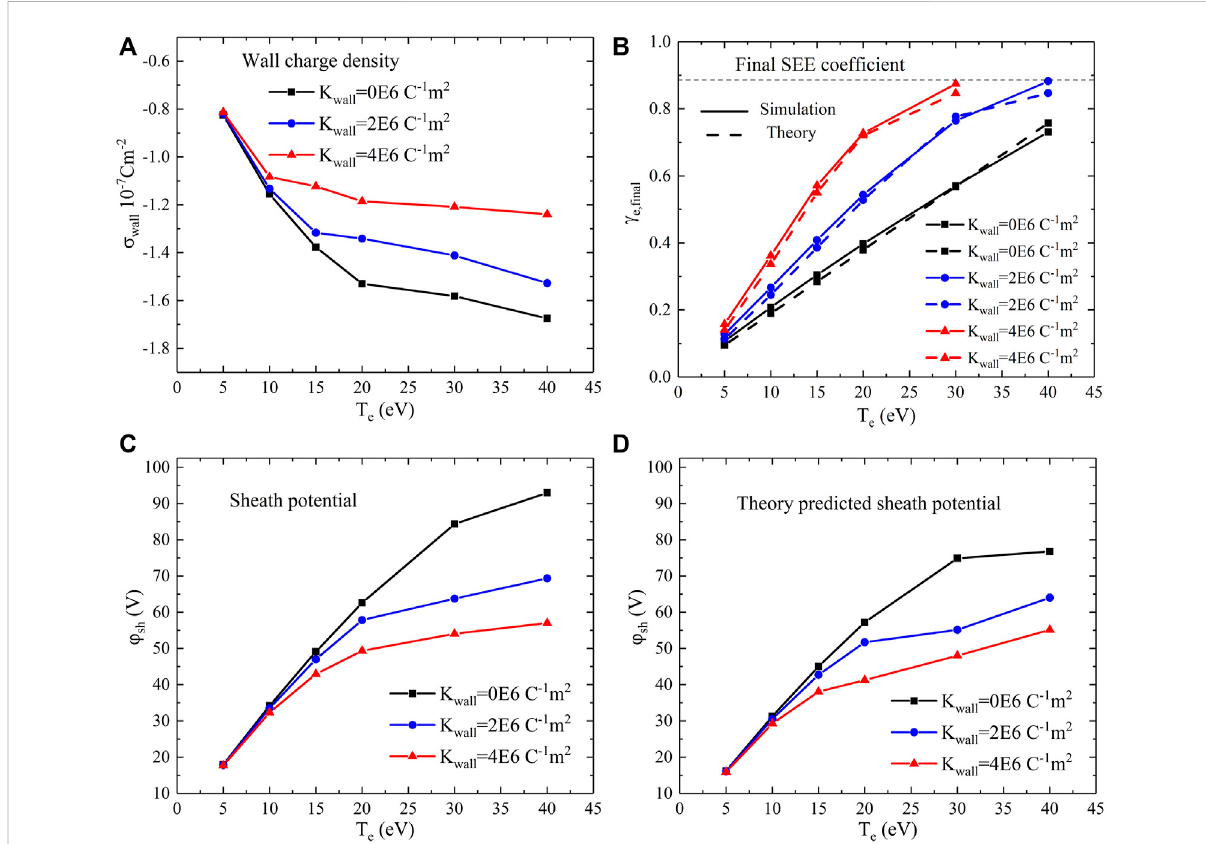
FIGURE 6 EmissivesheathpropertieswiththecombinedSEEmodel,forarangeof T e withdifferentwall-charging factors. (A) Wallchargedensity. (B) Final SEE coef fi cient after reaching convergence; solid lines show simulation results, and dashed lines show theory prediction. (C) Sheath potential from simulation. (D) Sheath potential predicted by the emissive sheath